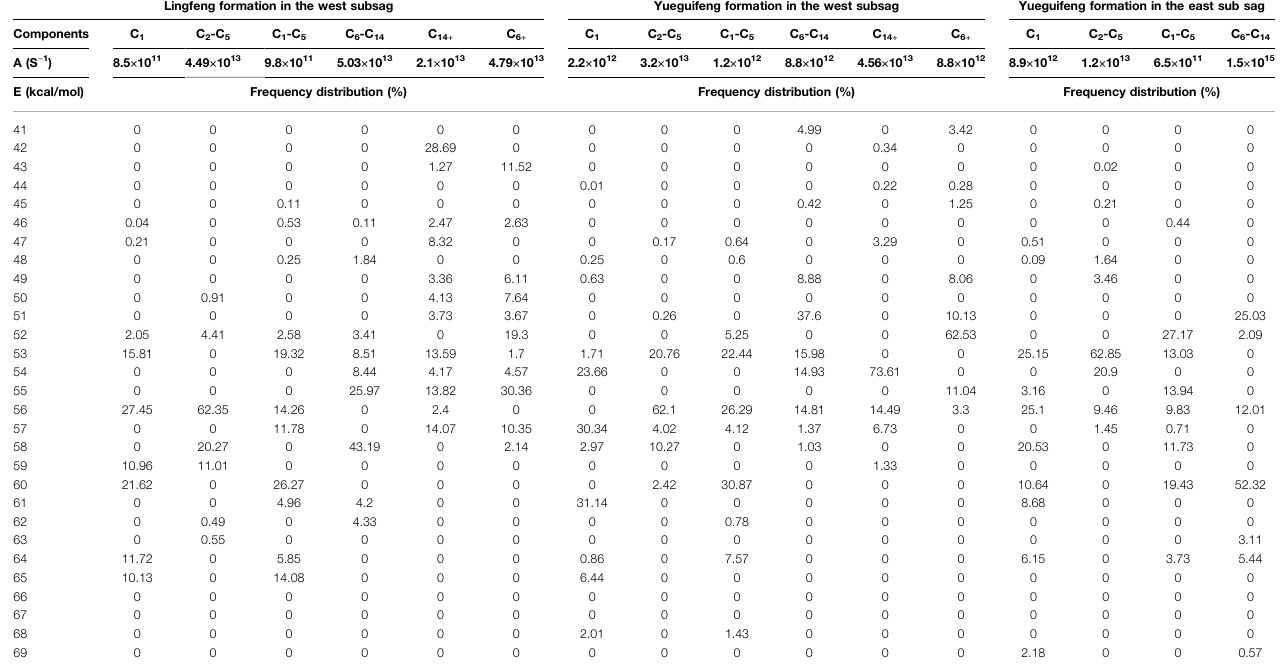
TABLE 3 | Data of kinetic parameters of hydrocarbon generation from source rocks in the Lishui Sag. Lingfeng formation in the west subsag Yueguifeng formation in the west subsag Yueguifeng formation in the east sub